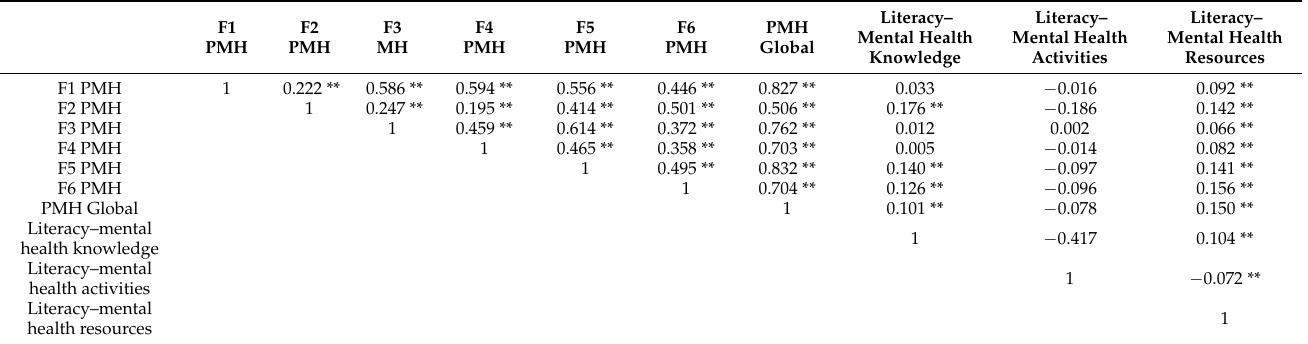
Table 3. Correlation between PMH and MHKQ.